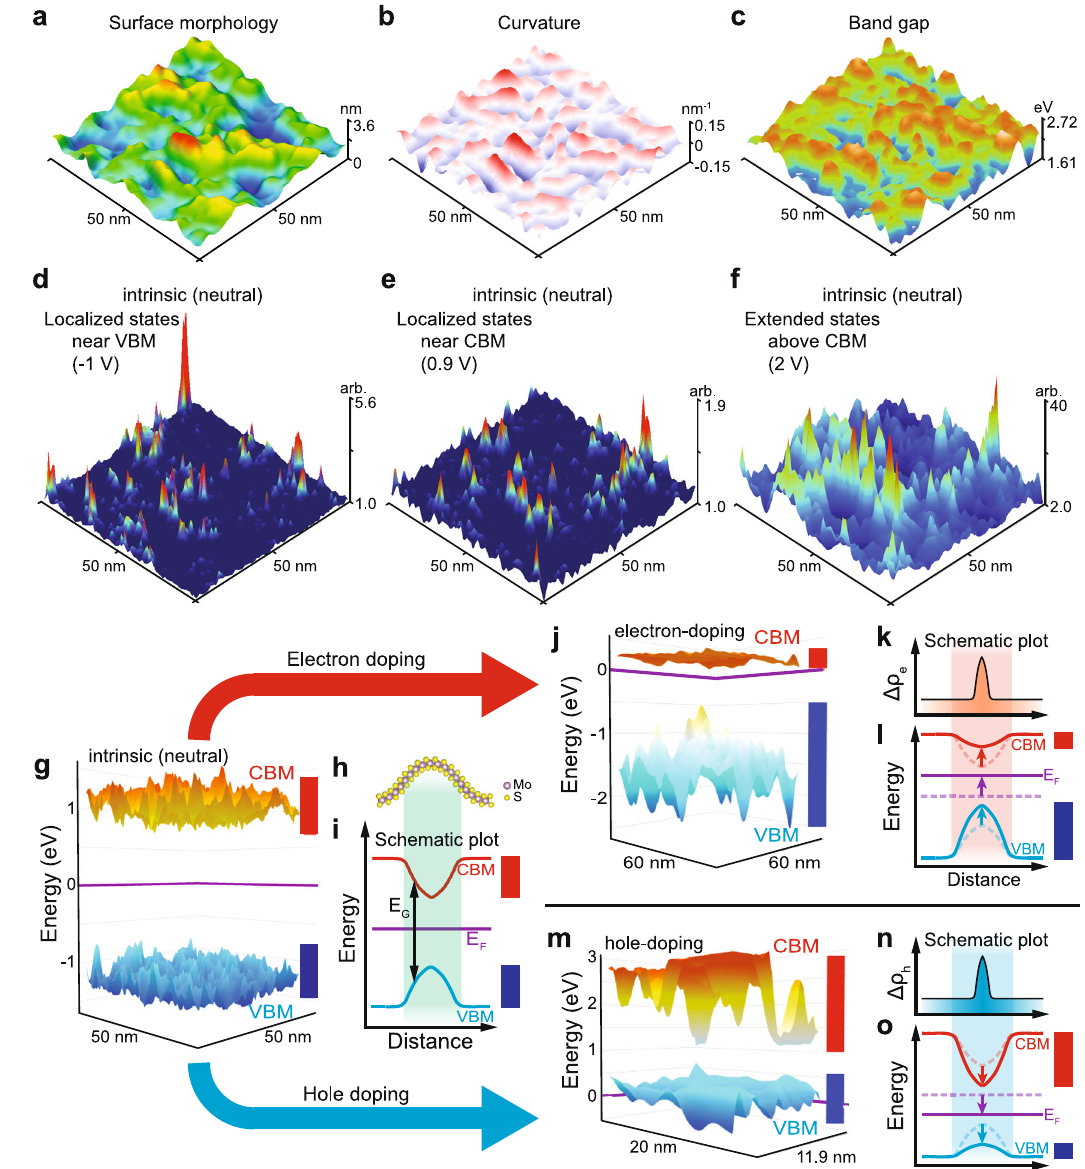
Fig. 1 | Curvature-induced charge localization and band edge fl attening in monolayer MoS2. a A 3D topographic STM image. b Local curvatures and c curvature-induced band gap fl uctuation in the area of ( a ). d – f STS maps for localized and extended states for the intrinsic state of disordered MoS 2 . Localized peaks near ( d ) valence and ( e ) conduction band edges. f Extended states covered the whole measured surface. g – i Curvature-induced band edge fl uctuation at a neutral state. g VBM and CBM in the area of ( a ). h Structural model of a single cylindricalcurvature, and ( i )itsCBM,VBM, and band gap( E G ). j – l Spatial fl attening of CBM via electron-doping. j Band edges at electron-doped state